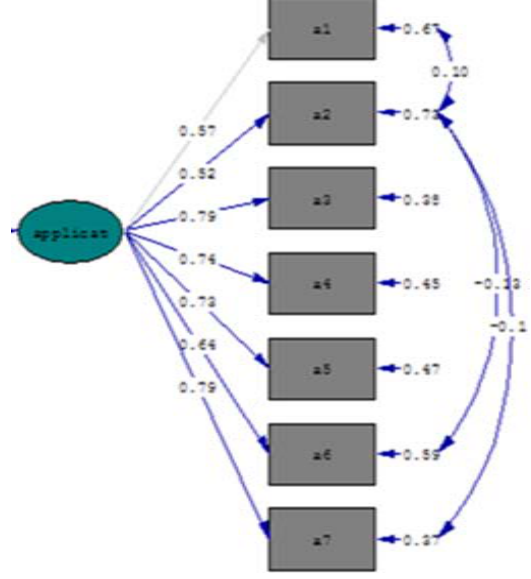
Fig. 1. Standard values of final model